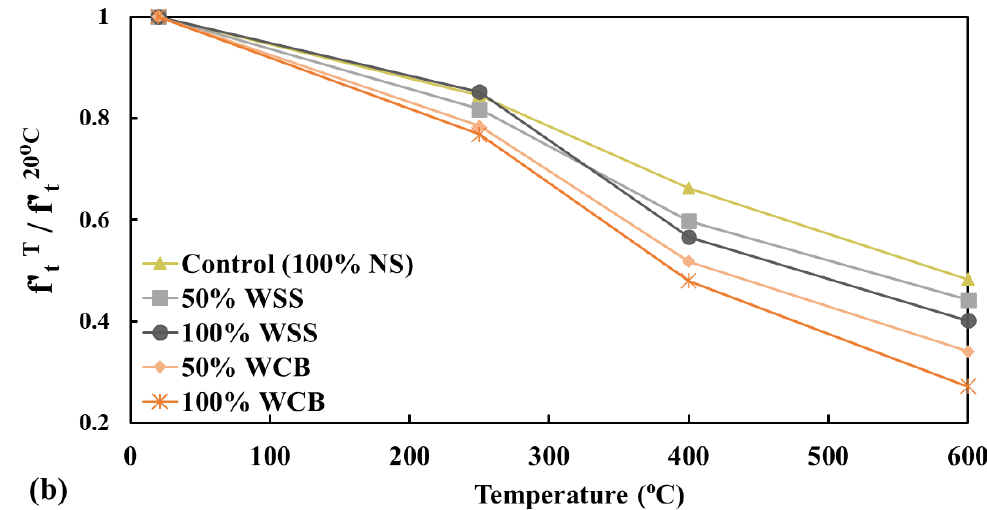
Figure 8. Tensile strength— 𝑓 𝑡′ ( a ) and normalized 𝑓 𝑡′ ( b ) of mortar mixes tested at room temperature after exposure to elevated temperatures.